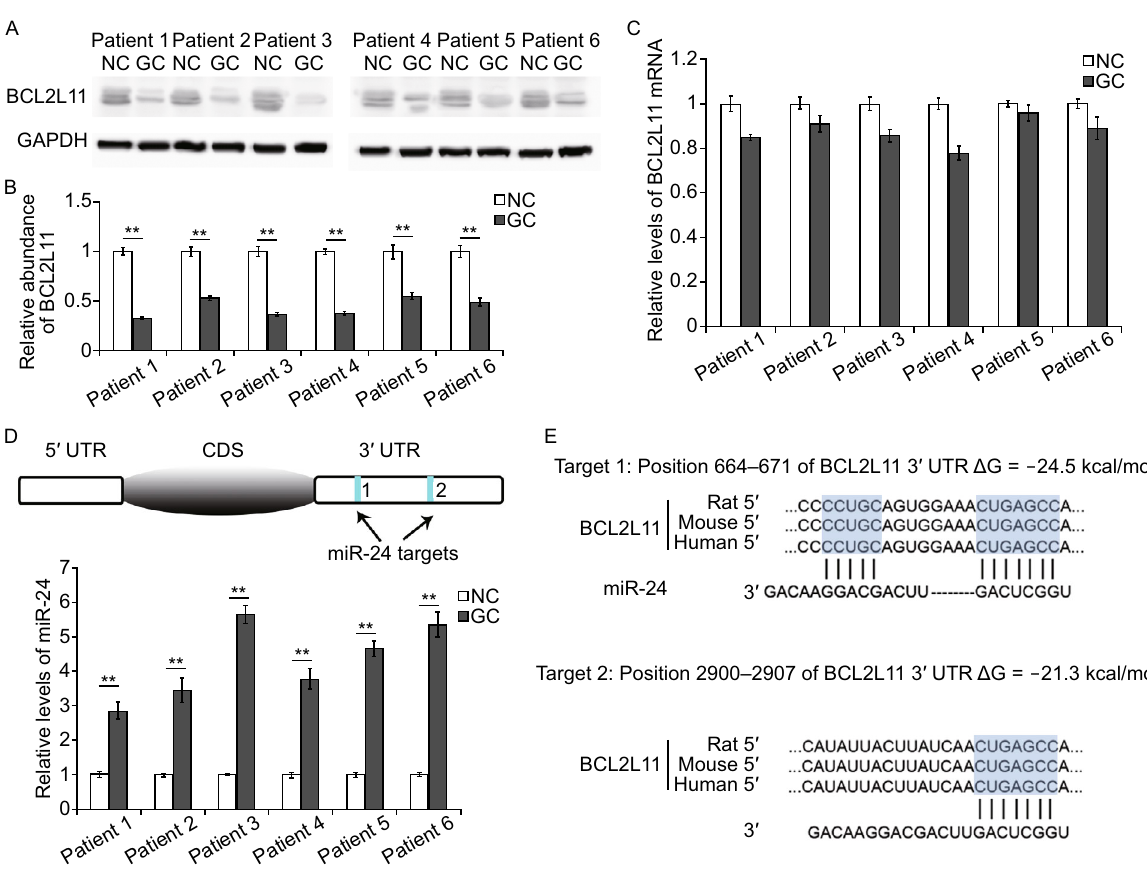
Figure 1. Inverse correlation between BCL2L11 and miR-24 in human GC tissues. (A) Western blot analysis of BCL2L11 expression in GC cancer tissues and the paired para-carcinoma tissues ( n = 6). (B) Quantitative analysis of (A). (C) Relative levels of BCL2L11 mRNA levels in GC tissues ( n = 6). (D and E) The predicted binding sites of miR-24 in the mRNA of BCL2L11 (D) and the base-pairing interaction between miR-24 and BCL2L11 mRNA (E). (F) Relative levels of miR-24 in GC tissues and para-carcinoma tissues ( n = 6). ** indicates P